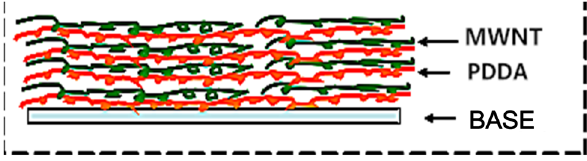
Figure 2: Schematic section structure of CNTFS.